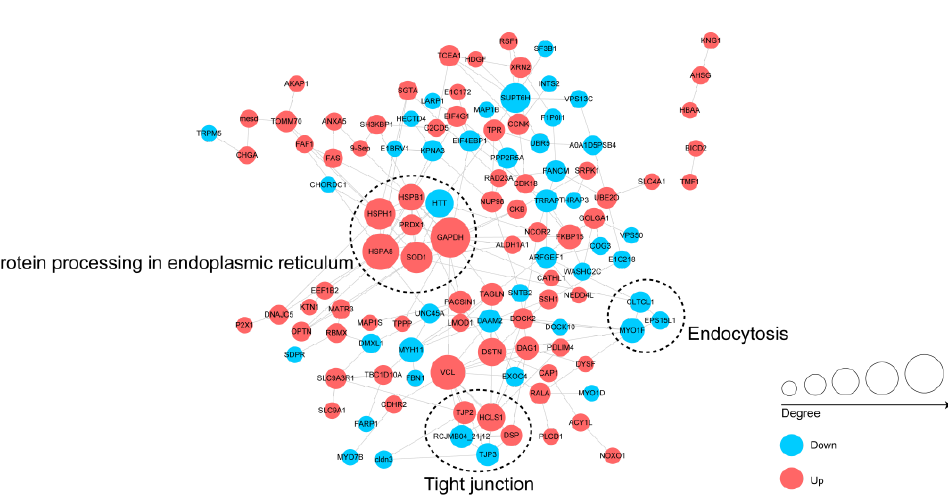
Figure 5. The top 25 protein domain enrichment analysis of DPPs. ( A ) The protein domain enrich- ment analysis of up-regulated DPPs. ( B ) The protein domain enrichment analysis of down-regu- lated DPPs. The x−axis is the Log2 -fold enrichment, and the y−axis is the protein domains. The bub- ble size indicates the number of DPPs, and the color indicates the p value.